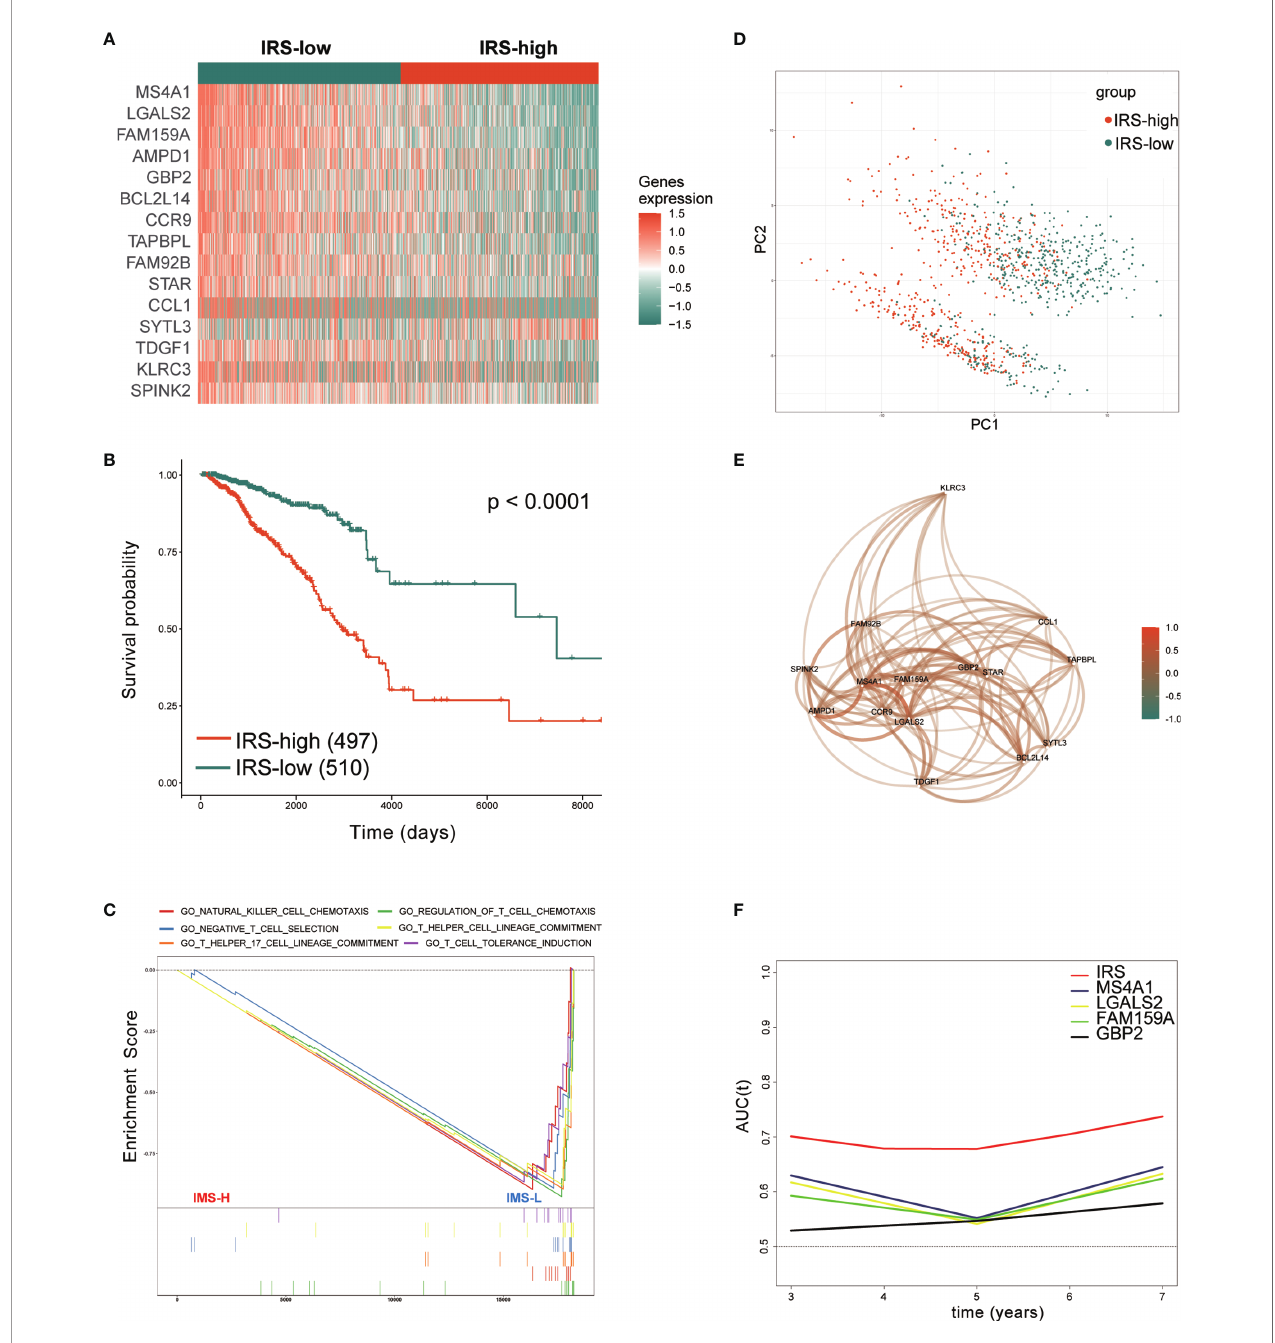
FIGURE 4 | Prognostic analysis of the immune-related gene signature in the training set. (A) Heatmap of the 15 immune-related prognostic genes between the high- and low-IRS groups in the training set. (B) Kaplan – Meier curves identi fi ed that patients in the high-IRS group exhibited better OS in the training set. (C) GSEA showed that several immune-related signaling pathways were inhibited in the high-IRS group. (D) PCA plot between the high- and low-IRS groups in the training set. (E) The correlation network of candidate genes. Correlation coef fi cients are shown in different colors. (F) tROC analysis showed that the IRS was an accurate variable for survival prediction. The four genes shown in the fi gure have the four highest AUCs among the 15 signature genes. TCGA, The Cancer Genome Atlas; GSEA, gene set enrichment analysis; HR, hazard ratio; IRS, immune-related risk score; High-IRS, high immune-related risk score; Low-IRS, low immune-related risk score; OS, overall survival; tROC, time-dependent receiver operating